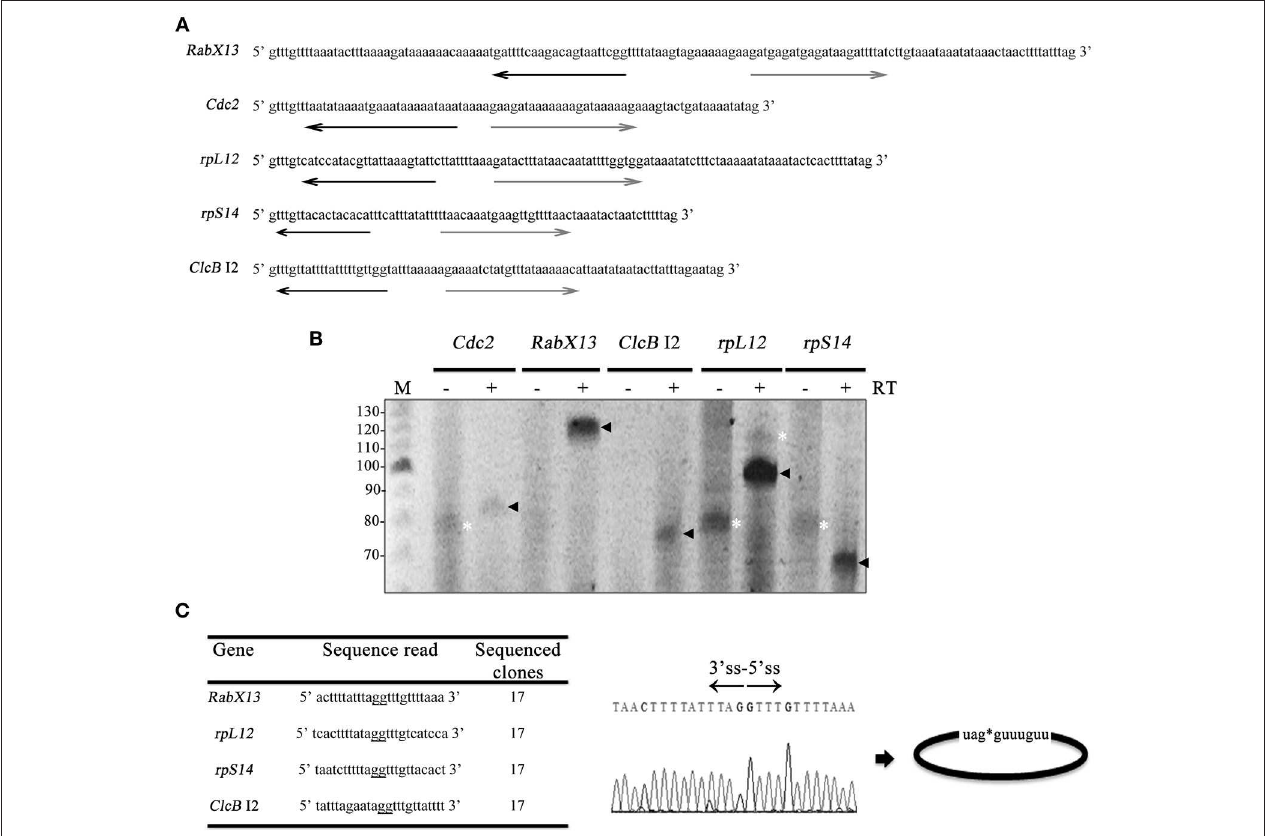
FIGURE 1 | E. histolytica full-length intronic circular RNAs. (A) Sequences of the introns analyzed in this work. Antisense (black) and sense (gray) outward-facing primers used in circular RT-PCRs. (B) 8% urea-polyacrylamide gels showing the amplicons obtained in the circular RT-PCRs alongside a 10 bp ladder (M). Black arrowheads indicate products ∼ 5–10 nt larger than the tailed lariats, e.g., flicRNAs. White asterisks indicate products that do not correspond to their respective intron sequences. PCRs with ( + ) and without ( − ) RT reactions are indicated. (C) Sequence reads of amplicon clones showing ligation points between the 5 ′ ss and the 3 ′ ss (underlined gg residues; also denoted by an asterisk), suggesting full-length intronic circular RNA molecules (right). The electropherogram corresponds to flicRX13.